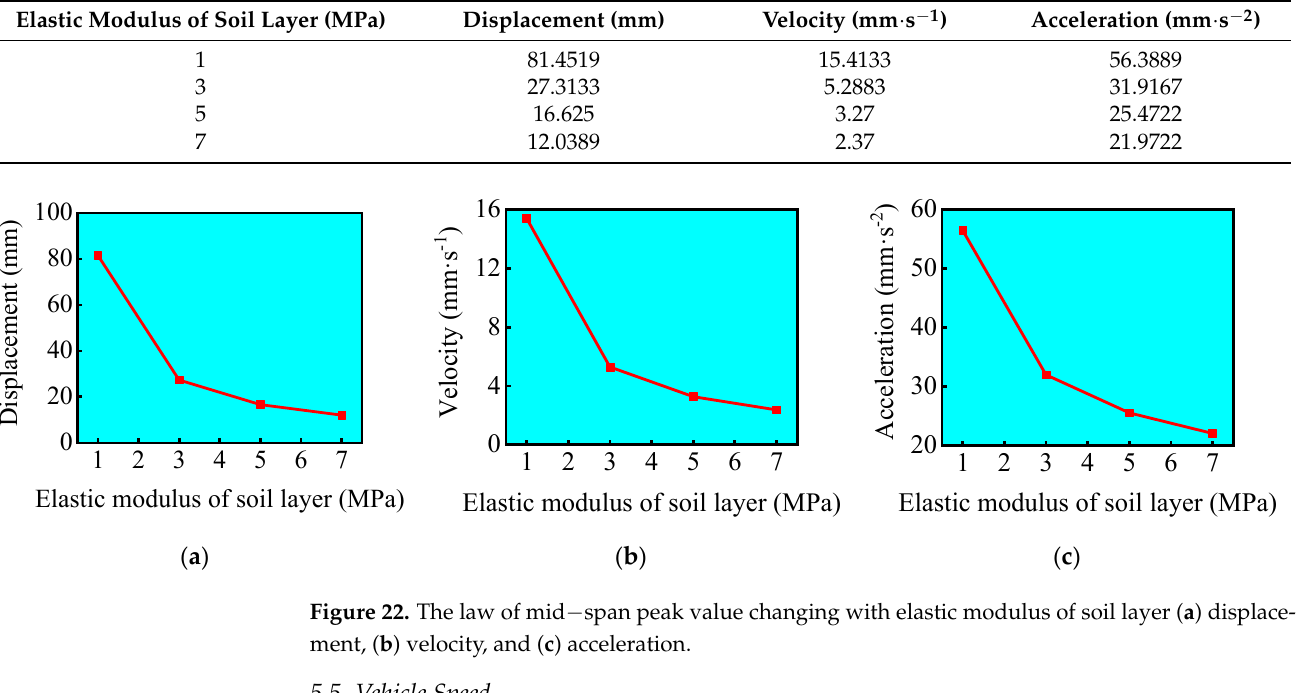
Figure 21. Peak value variation rule of different measuring points when the elastic modulus of soil layer changes ( a ) displacement, ( b ) velocity, and ( c ) acceleration. Table 6. Results of peak displacement, velocity, and acceleration at the mid − span measuring point when the elastic modulus of soil layer changes.